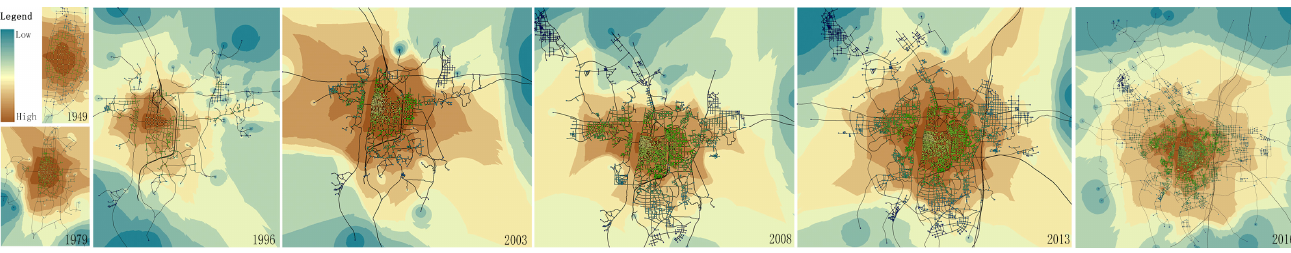
Figure 4. Map of traffic accessibility.